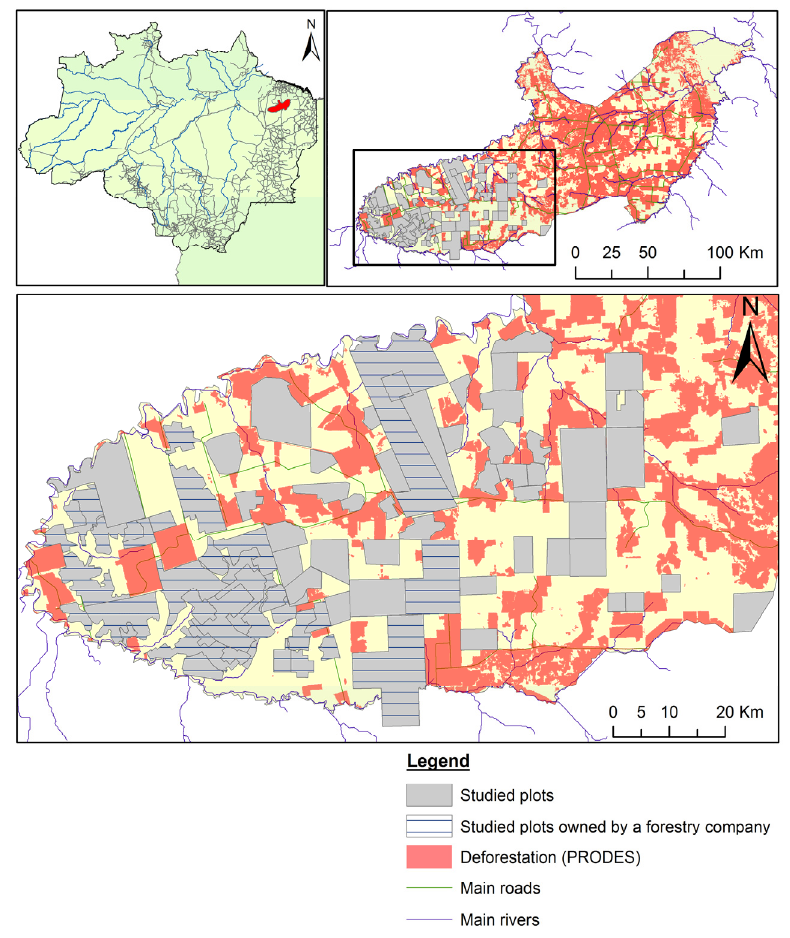
Figure 1. Localization of the studied plots in the municipality of Paragominas.